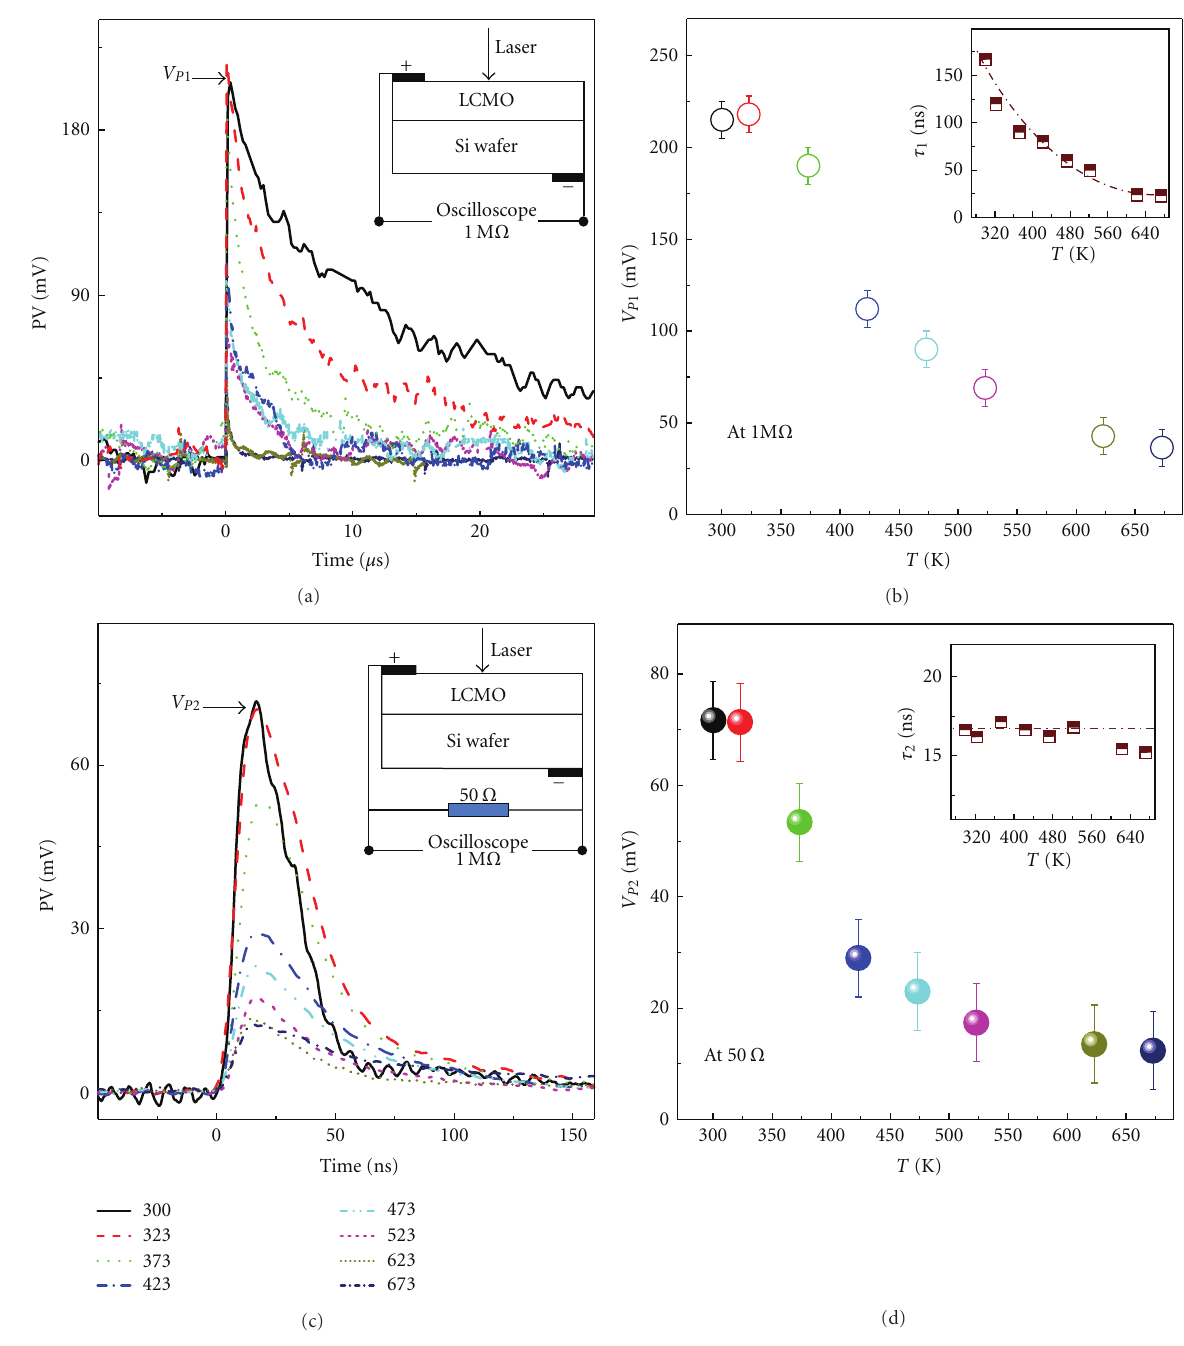
Figure 2: Photovoltaic responses for LCMO/SiO x /Si heterojunction at di ff erent temperature from 300 to 673 K under the 248 nm laser illumination recorded by an oscilloscope terminated into (a) 1 M Ω and (c) 50 Ω . The insets of (a) and (c) display the schematic measurement circuits. (b) and (d) present the dependence of PV peak values V p 1 and V p 2 on the temperature, respectively. The insets display the temper- ature dependence of rising time τ 1 and τ 2 of PV pulses shown in (a) and